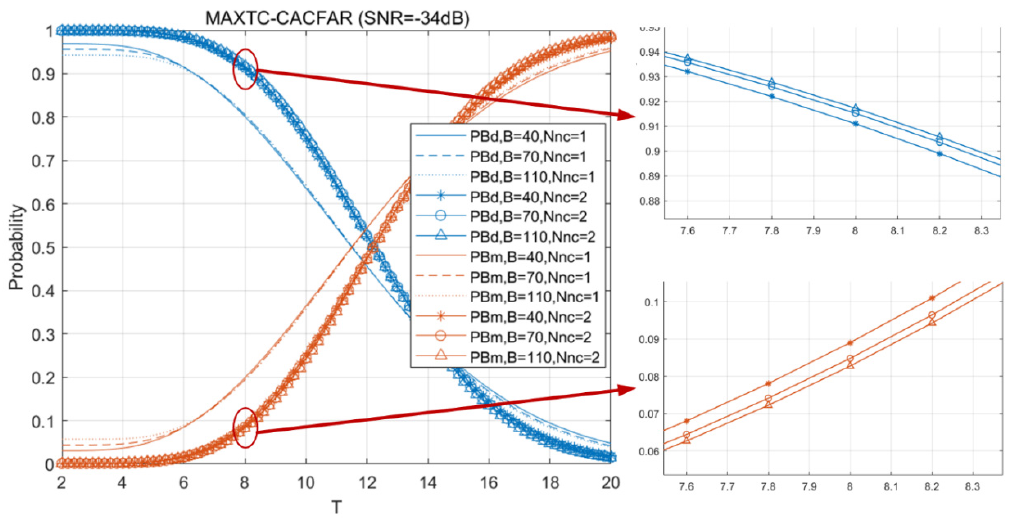
Figure 11. P (cid:2886)(cid:2913)(cid:2928) and P (cid:2886)(cid:2916)(cid:2911) versus multiple parameter T .